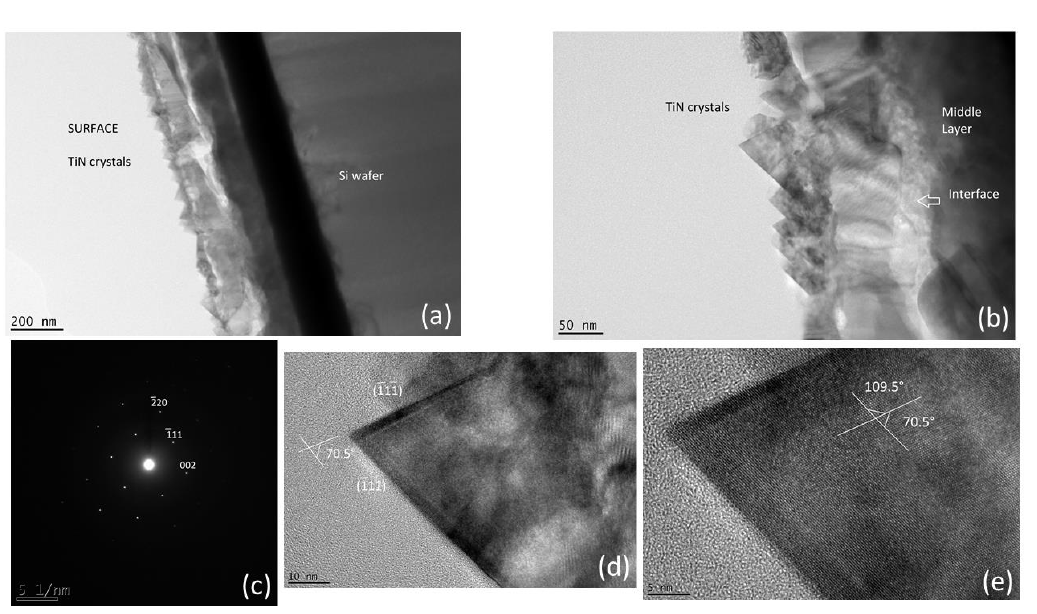
Figure 10. Cross-sectional transmission electron micrograph of the Mo–Ti bilayer film heated at 800 °C and exposed to (Ar-31%N 2 -6%H 2 ) plasma for 1 h 30 min ( a ), ( b ). SAED pattern of TiN crystallites ( c ) and high-resolution TEM (HRTEM) image of TiN crystallites ( d ), ( e ).